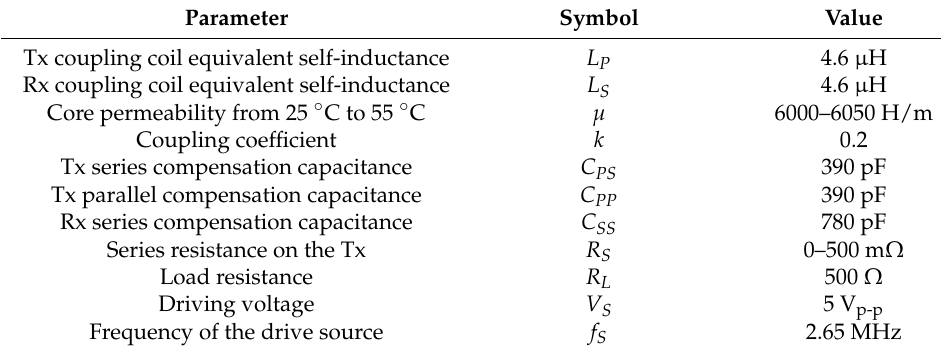
Table 1. Parameters of LCC-S-based wireless power transfer system.